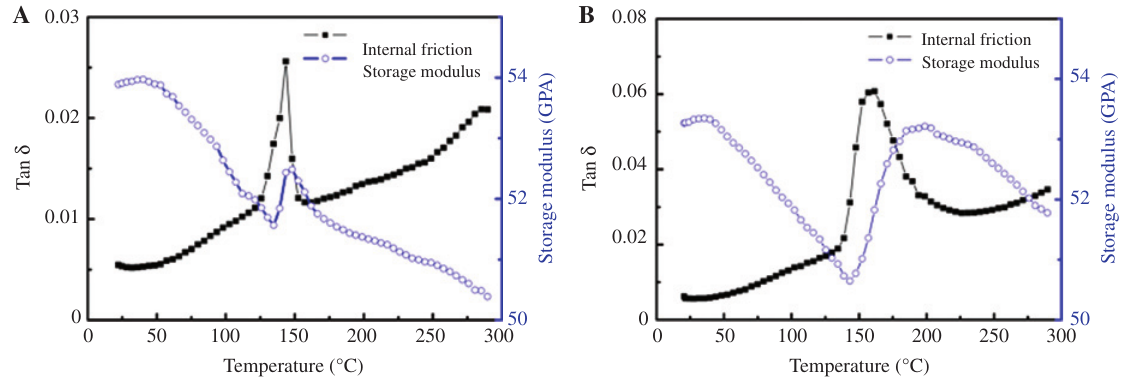
+TiNi /Al composite as a function of the temperature from 20 ° C to 290 ° C at the frequency of p f